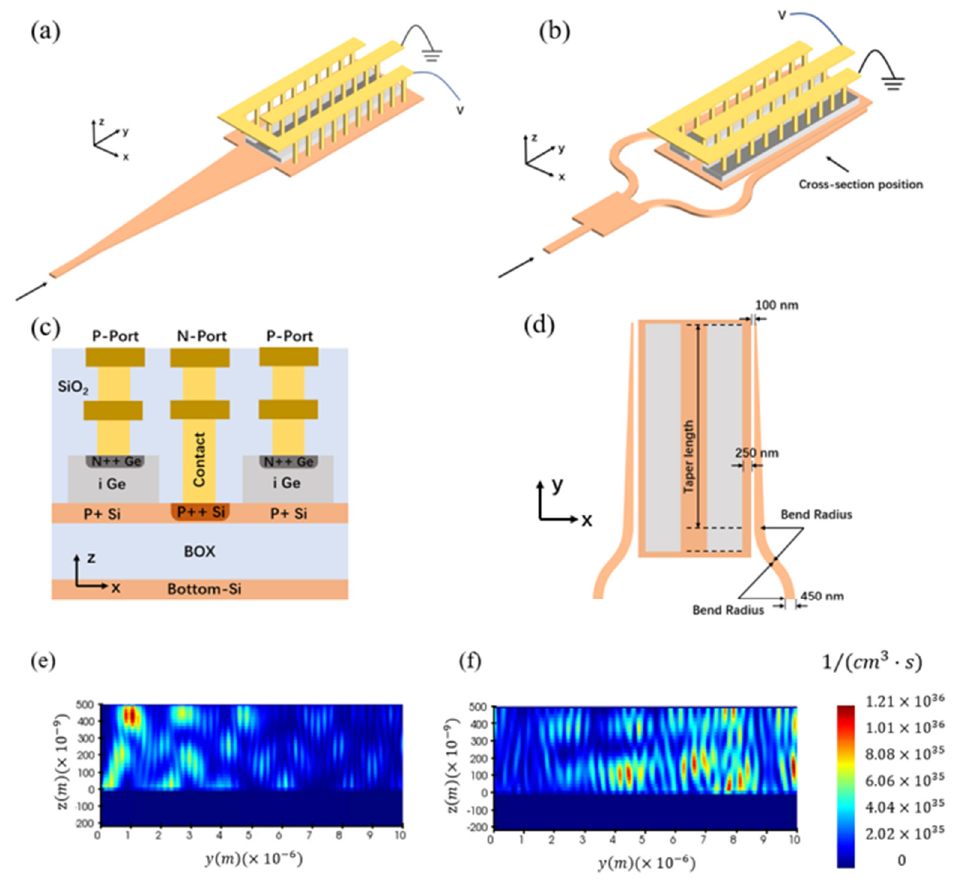
Figure 1. Perspective view of ( a ) the conventional butt-coupled detector with 50 µ m-long taper and ( b ) the proposed mode-evolution-based coupled detector. ( c ) The cross-section of the proposed structure taken in the absorption region. ( d ) The top-view of the proposed structure, where the electrodes are omitted. ( e , f ) show the optical generation rate (photogenerated electron-hole pair density per unit time) comparison in the absorption region of ( e ) the conventional butt-coupled detector and ( f ) the proposed mode-evolution-based coupled detector.